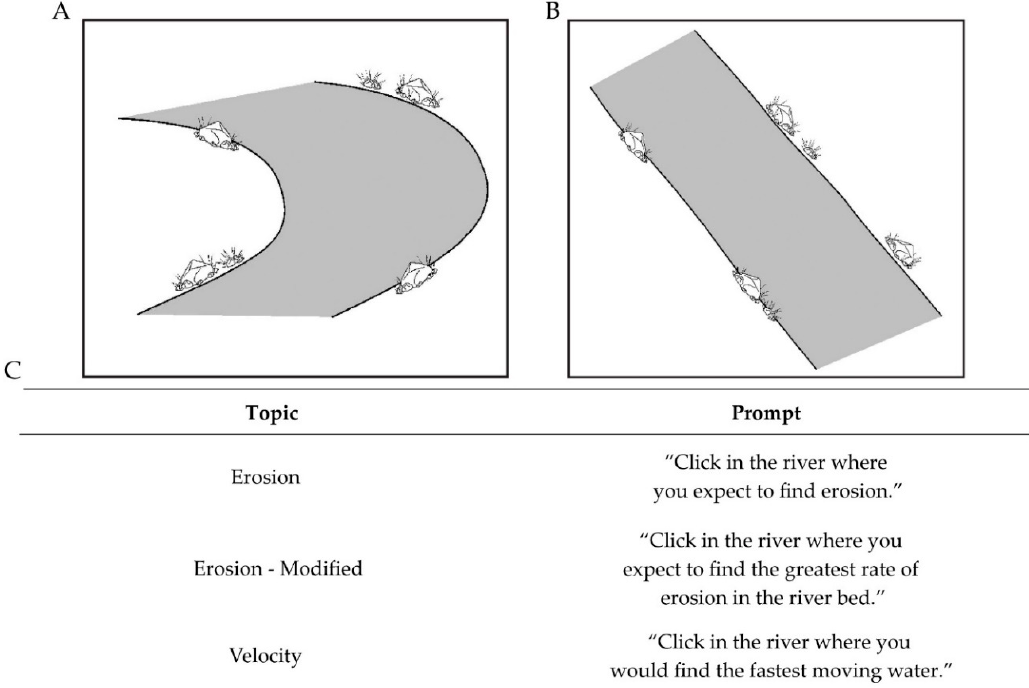
Figure 2. Plan view diagrams of curved ( A ) and straight ( B ) river channels used to probe students understanding of erosion and velocity in a river and corresponding prompts ( C ) for each